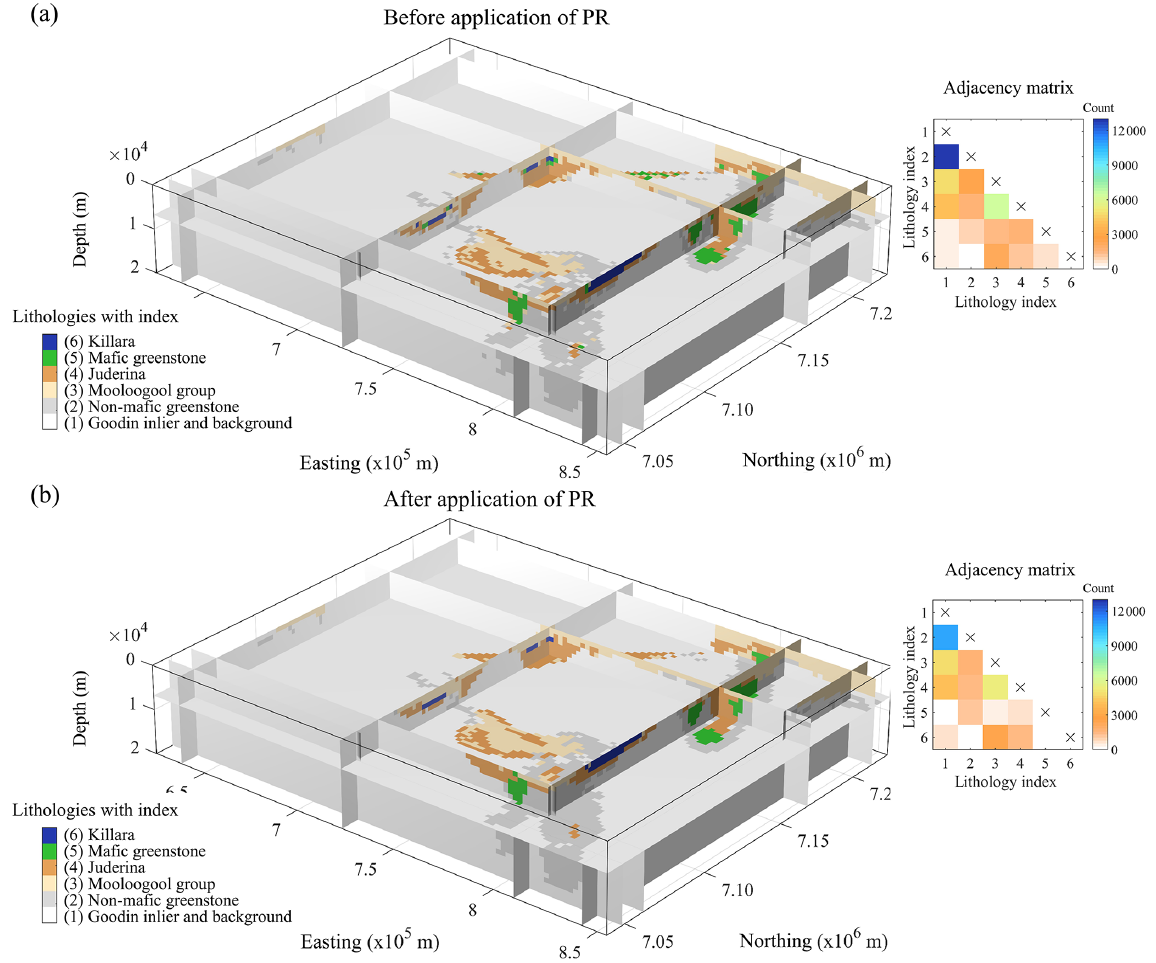
Figure 9. Recovered lithologies before post-regularization (a) and after (b) next to the corresponding adjacency matrix (right-hand side). The indices used to designate lithologies are indicated in the legend of the volume (left-hand